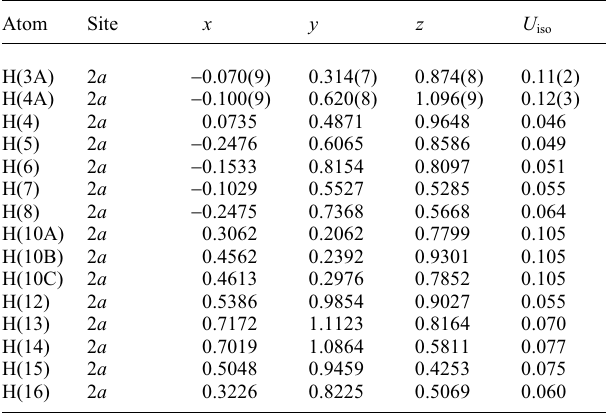
Table 2. Atomic coordinates and displacement parameters (in Å 2 )